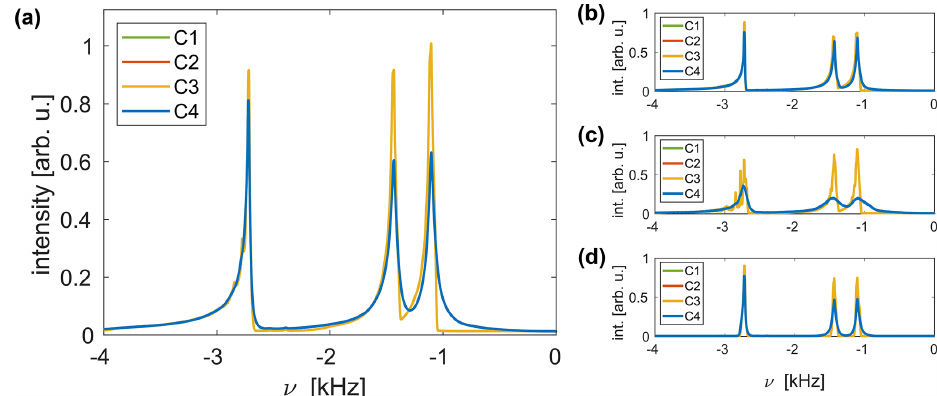
Figure 10. Simulated FSLG decoupled proton spectra of a three-spin system at a resonance frequency of 600MHz for a 3.2mm MAS probe, assuming a MAS frequency of 12.5kHz for C1–C4. The rf field strength along the magic angle was set to 125kHz. (a) Spectrum for the full rz plane. Significant additional line broadening is observed when amplitude modulations are taken into account (C2 and C4). The two remaining cases are indistinguishable, indicating that rf phase modulations do not contribute to the residual linewidth. (b, c ,d) Contributions from radial slices (all z values for given r ) at r = 0 . 65 (b) and 1.3mm (c) , as well as the spectrum of a spatially restricted sample (central third along the rotor axis; z = − 1 . 35–1.35mm; all r values; d ). Stronger line broadening is observed towards the edges of the rotor where rf modulations are more pronounced. Significantly narrower lines are obtained for the restricted sample; however, considerable broadening is still observed when time-dependent rf amplitude modulations are taken into account (C2 and C4). The observed splitting of the line for C1 and C3 in (c) can be attributed to the distribution of the isotropic chemical shift scaling factors in this radial slice (see Fig. S8 for